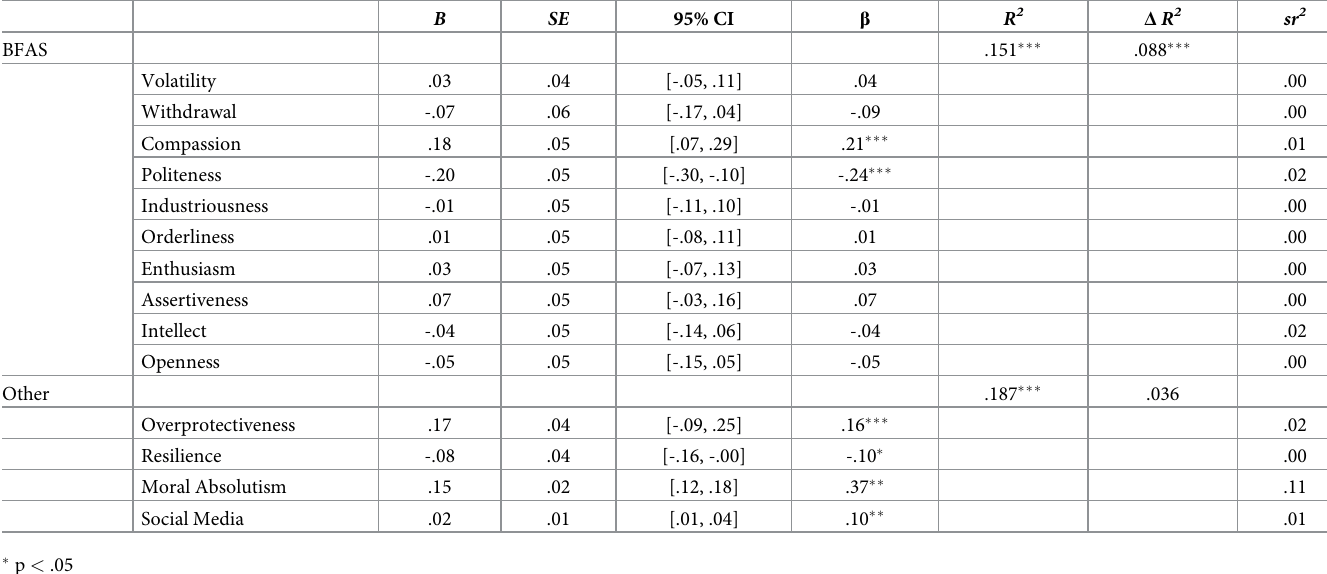
Table 5. Step 3 of the hierarchical multiple regression of BFAS, parenting, and personal factors with